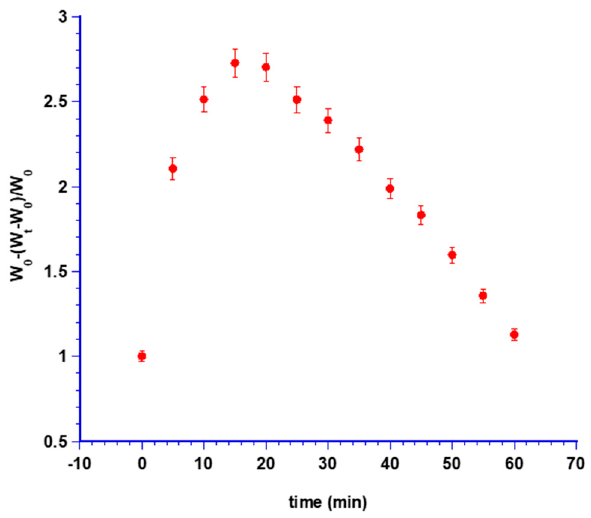
Figure 7. Swelling index measured as weight increase versus time.